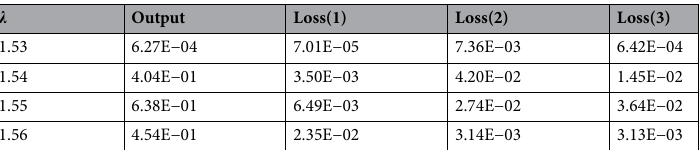
Table 1. Example of data generated by the photonic component simulator. (cid:31) is the wavelength of one specified optical signal. The Output column is output transmission, and Loss1, Loss2, and Loss3 represent the crosstalk of four directions of the agent going